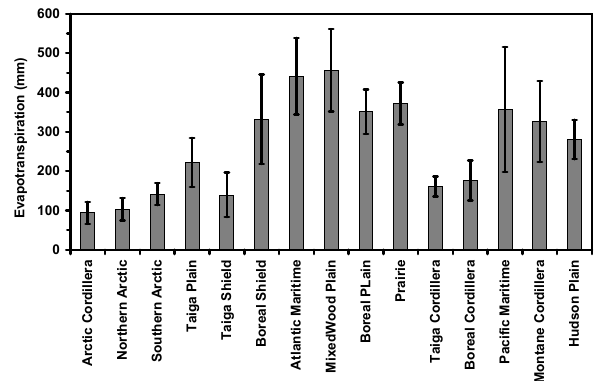
Fig. 10. Mean annual evapotranspiration (1979–2008) modeled for the 15 ecozones in Canada. The error bars represent one standard deviation of ET among the pixels in each